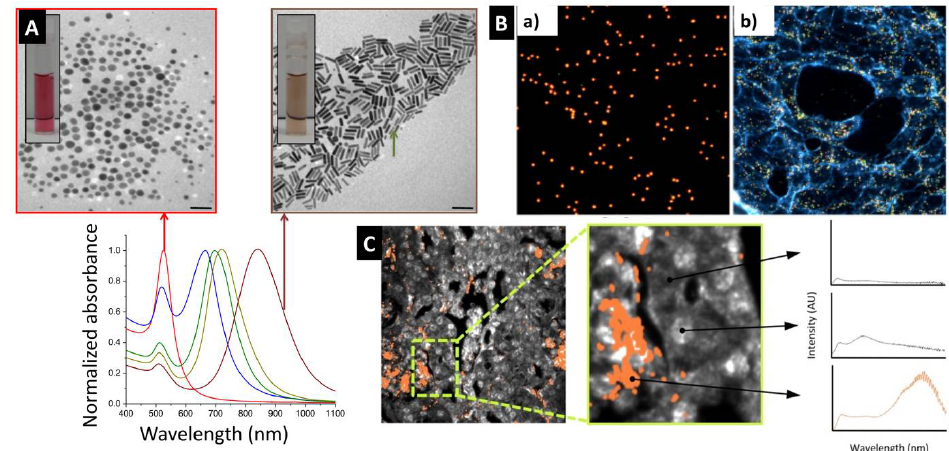
Figure 2. ( A ) Tunable optical properties of GNP. While suspension of spherical GNP (18 nm in diameter) exhibit a red color and plasmonic absorption peak around 520 nm, suspension of gold nanorods exhibit brown color with tunable optical extinction in the visible-infrared region of the spectrum. ( B ) Dark field image of GNP in solution ( a ) and inside cells ( b ). ( C ) Hyperspectral microscopy with adaptive detection analysis showing the location of gold nanorods tracked using their unique optical fingerprint (plasmonic optical extinction in the NIR) in orange and grayscale for tissue background. Images in B and C were reproduced from Refs. [18,19], respectively (Creative Commons Attribution 4.0 International Public License (CC-BY 4.0). ( B ) Reproduced from Zamora-Perez et al.